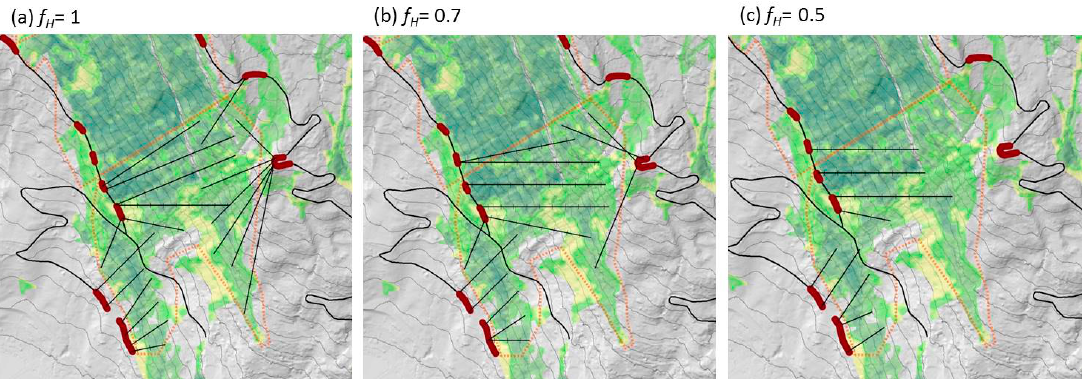
Figure 9. Harvesting layout for area 1 (Rigi) for different f H values (a: = 1, b: = 0.7, c: = 0.5) (helicopter wood extraction factor) (weighting: λ SL = 0.25, λ DH = 0.25, λ C = 0.50). The darker green areas have a larger volume per TP. The corresponding properties of those layouts can be found in Table 6.